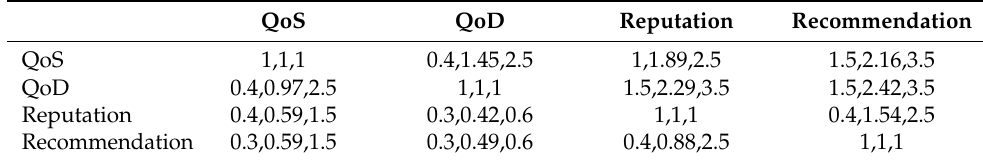
Table 6. FPCM for Scenario 1.